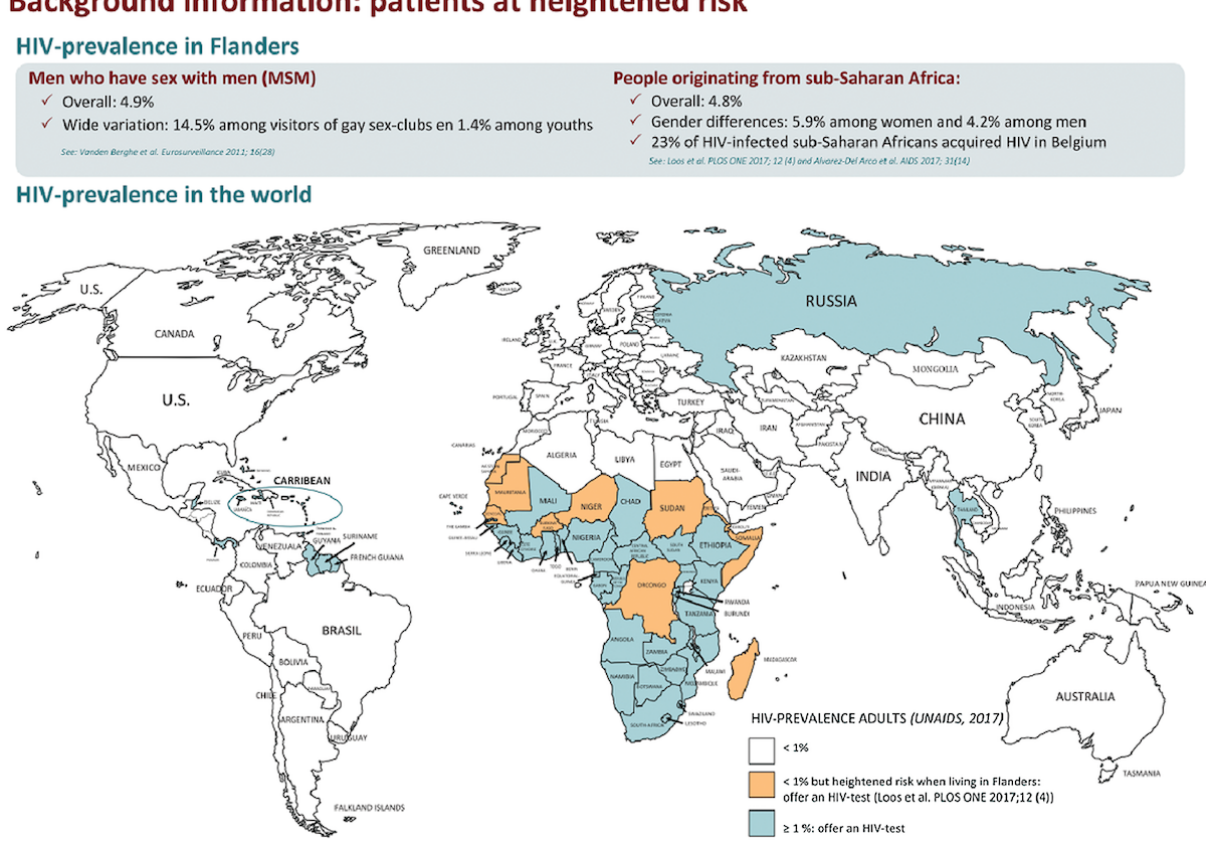
Figure 4. Advice HIV-testing by GPs (back